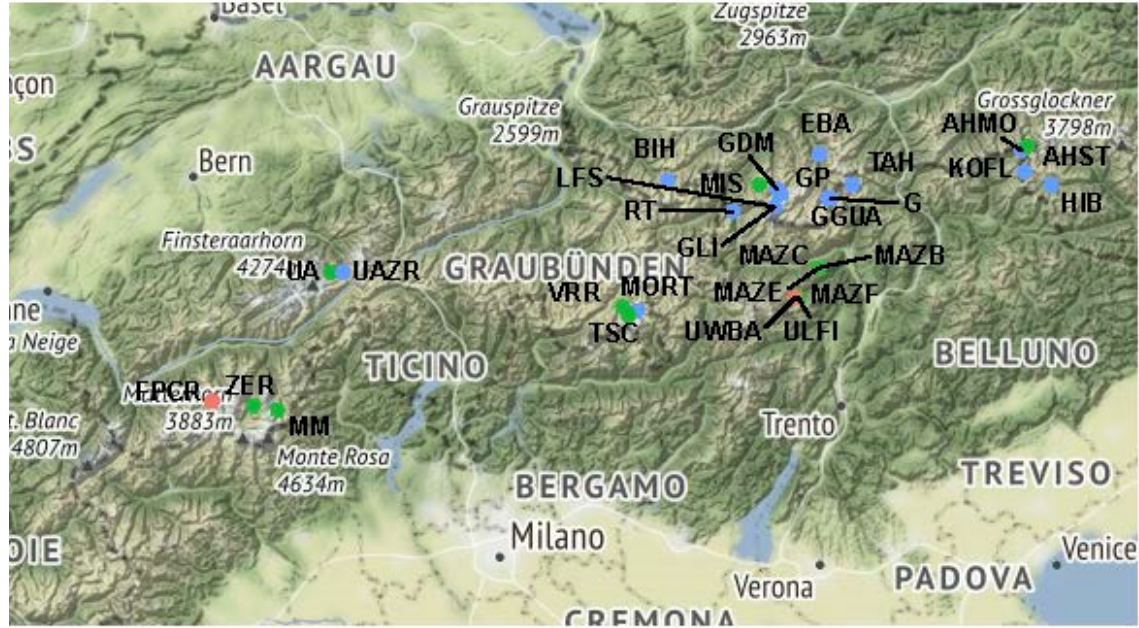
Figure 1. Map showing the localization of the tree collection sites. The sites are in the Swiss, the Austrian and the Italian alps (©Google Maps 2021): The information on each site are presented in Table 1. In green the site with only cembran pine ( Pinus cembra L.), in red the site with only larch ( Larix decidua Mill.), in blue with both species. Table 1. Number of trees and wood samples. Trees and wood samples analyzed for each age class and in total. TRW and the three cellulose isotopes were measured in all samples. PICE ( Pinus cembra L.), LADE ( Larix decidua Mill.).